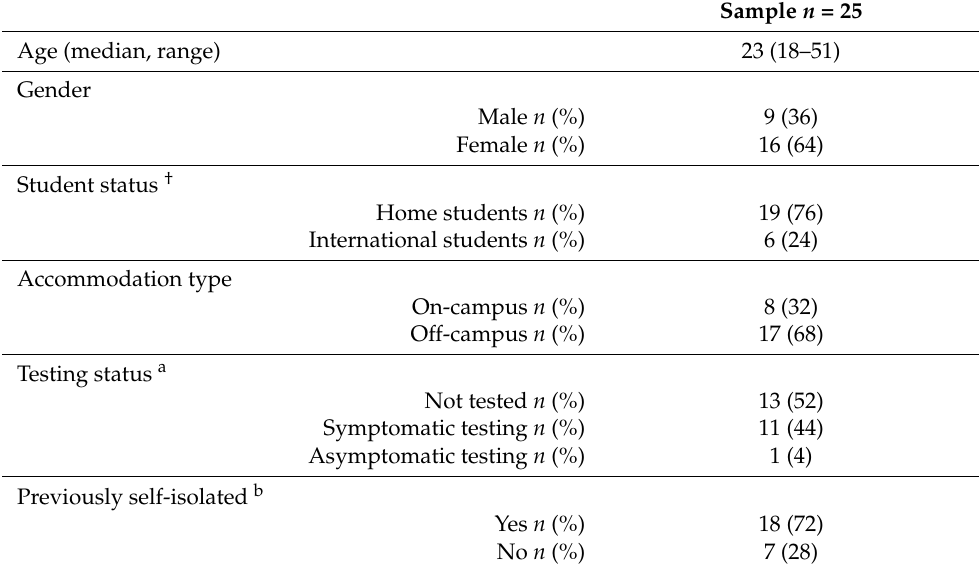
Table 1. Characteristics of